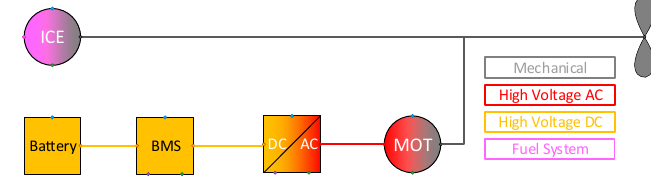
Figure 5. Parallel hybrid propulsion system.